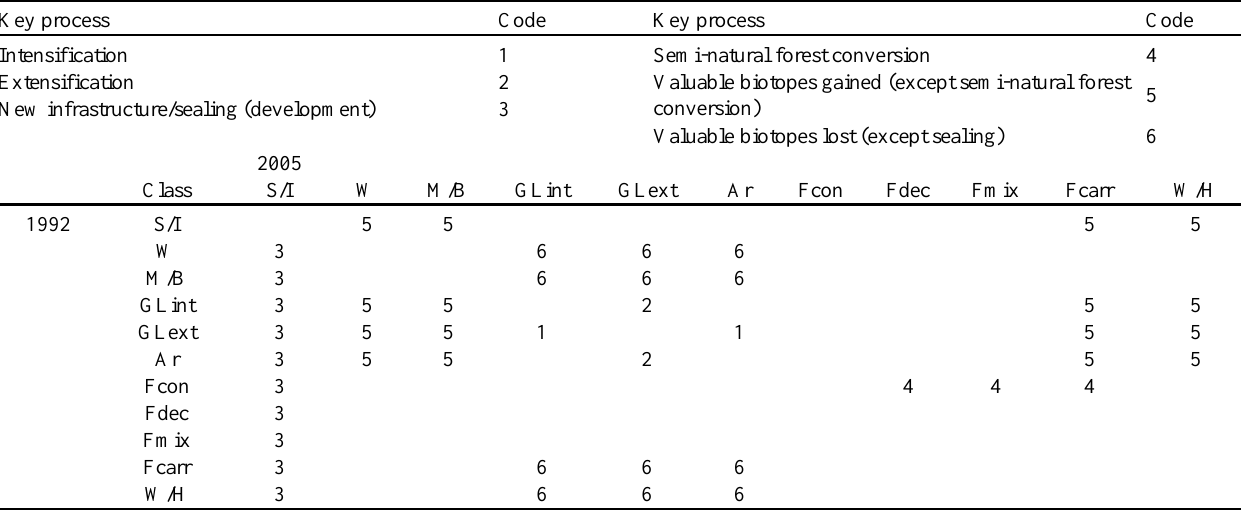
Table 3 . Definition of key processes (for class abbreviations and descriptions, refer to Table 2). Key